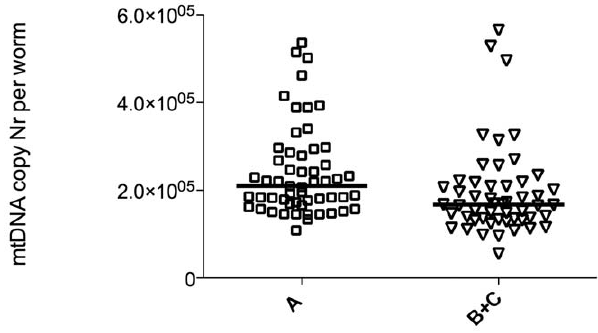
Figure 3. Successfully ageing (class ‘‘A’’) old worms have higher mtDNA copy number than animals showing motility defects. Comparison of mtDNA copy number in JK1107 worms from the same cohort (identical genotype and environment) scored at the same age (day 12) but found to be in different motility classes. Graph shows scatter and median of individual worm copy number because data are not normally distributed. Class ‘‘A’’ worms have statistically significantly higher mtDNA copy number (median 210,000 vs. 170,000 copies) than class ‘‘B’’ and ‘‘C’’ animals (P , 0.001, Mann-Whitney test). The n-numbers for class ‘‘A’’ and ‘‘B’’/’’C’’ were 55 and 52 respectively, although we typically found very few class ‘‘C’’ worms on day 12.